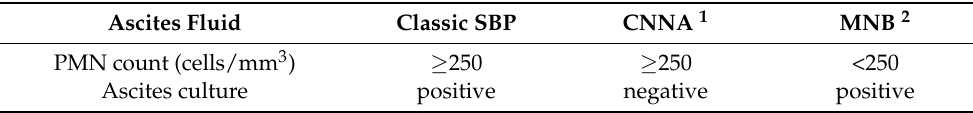
Table 1. Three types of